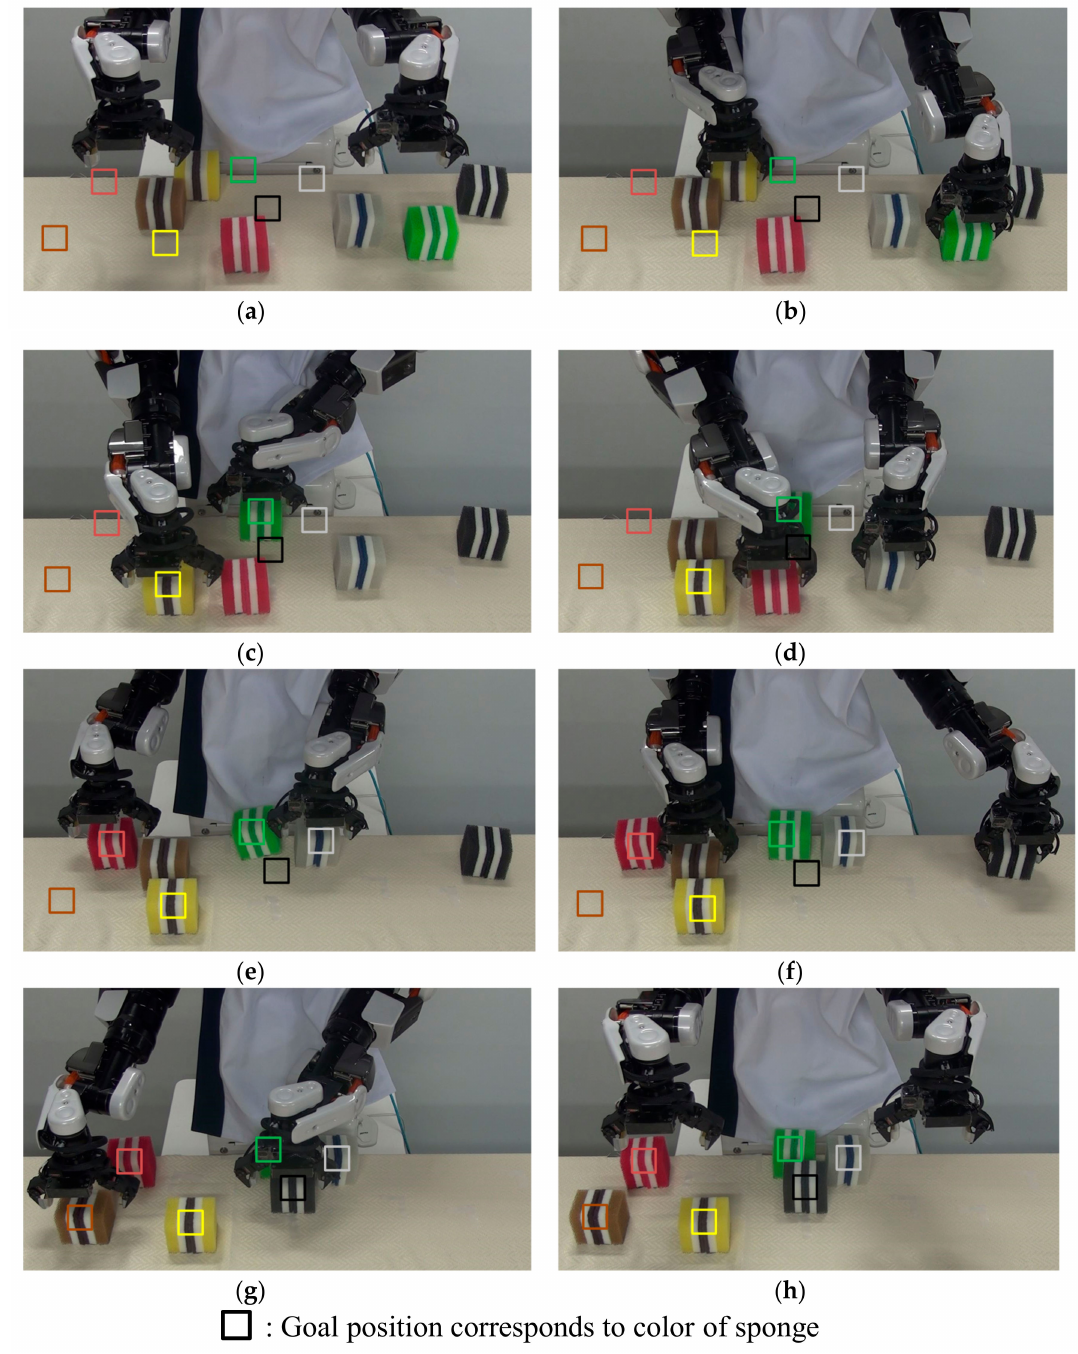
Figure 9. Verification Experiment 2: ( a ) initial configuration; ( b ) picking the yellow and green blocks; ( c ) placing the yellow and green blocks; ( d ) picking the red and grey blocks; ( e ) placing the red and grey blocks; ( f ) picking the brown and black blocks; ( g ) placing the brown and black blocks; and ( h ) final